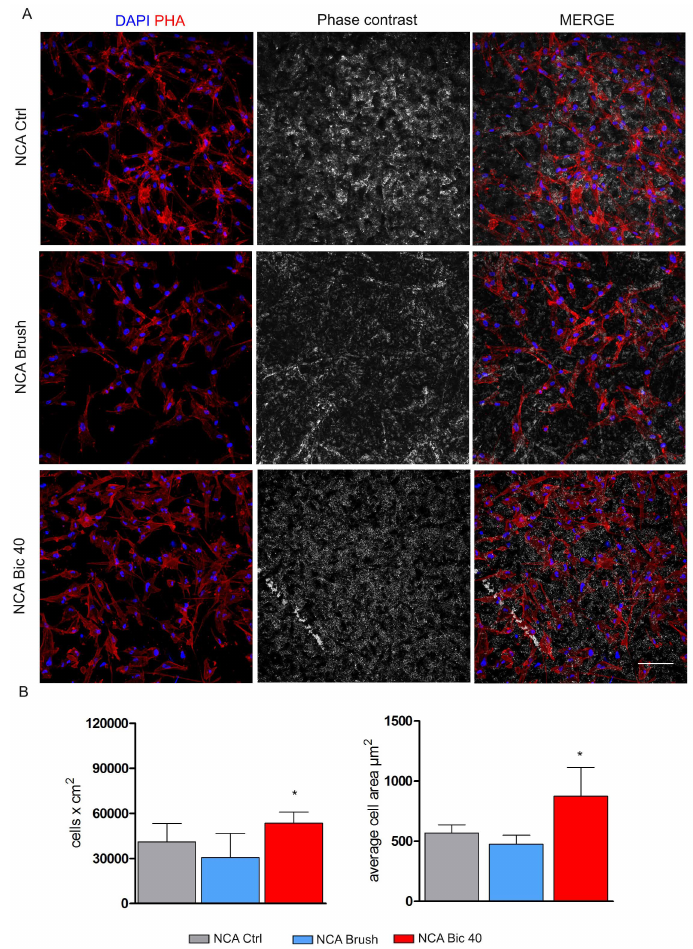
Figure 4. Evaluation of hDPSCs morphology and proliferation on NCA titanium surfaces. ( A ) hDPSCs morphology was assessed by confocal microscopy with phalloidin staining after 7 days of culture on NCA Ctrl, NCA Brush and NCA Bic40 surfaces. ( B ) Cell proliferation on titanium disks was measured by counting cell nuclei after DAPI staining. Histograms show cell numbers and average cell area after 7 days of culture on titanium surfaces from the three experimental groups. Values represent mean ± SD. * p < 0.05 NCA Bic 40 vs. NCA Brush, NCA Bic40 vs. NCA Ctrl; one-way ANOVA followed by the Newman-Keuls post-hoc test. Scale bar: 100 µ